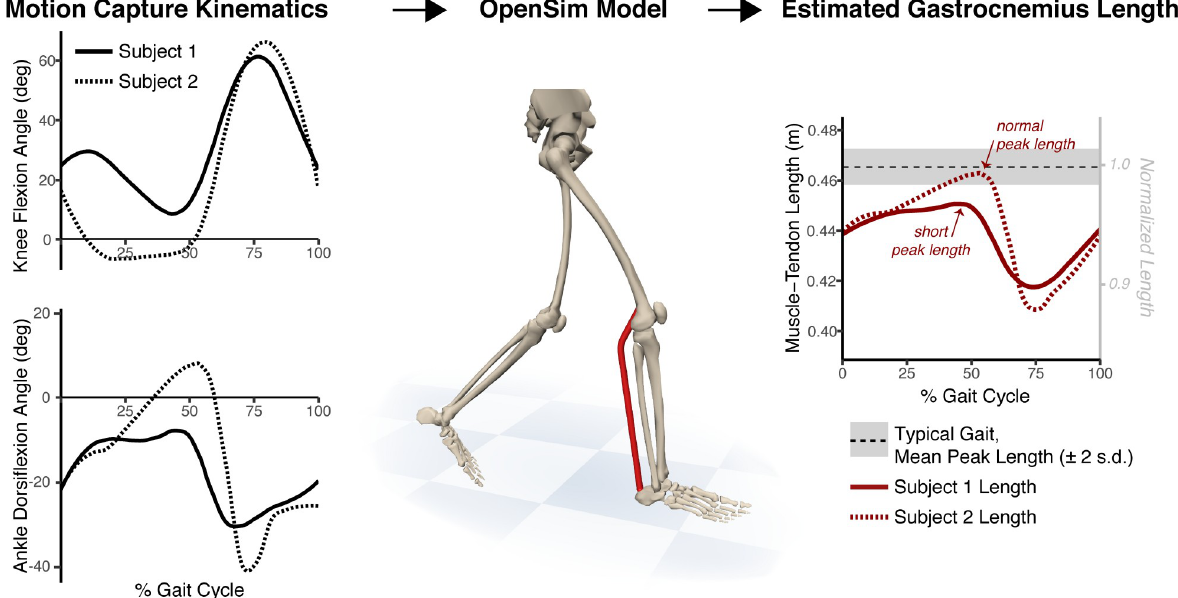
Fig 2. Method to estimate gastrocnemius length. Motion capture kinematics for knee flexion and ankle dorsiflexion were input to an unscaled OpenSim model [17, 18] to estimate gastrocnemius medialis muscle-tendon length over the gait cycle. These lengths were normalized to the average peak length computed for typical gait. Limbs whose peak length was at least 2 standard deviations below the typical mean (i.e., under the gray band in right the panel) were labeled as having a “short” gastrocnemius. Our supplemental “gastrocnemius length calculator” spreadsheet (S1 Worksheet) takes as input the motion capture kinematics pictured in the left panel and produces a gastrocnemius length graph as shown in the right panel. Two sample knee and ankle kinematic trajectories are shown. Subject 1 (solid lines) has increased knee flexion and ankle plantarflexion and a short peak gastrocnemius length. Subject 2 (dotted lines) has increased plantarflexion in early stance and throughout swing but attains normal peak gastrocnemius length in late stance.